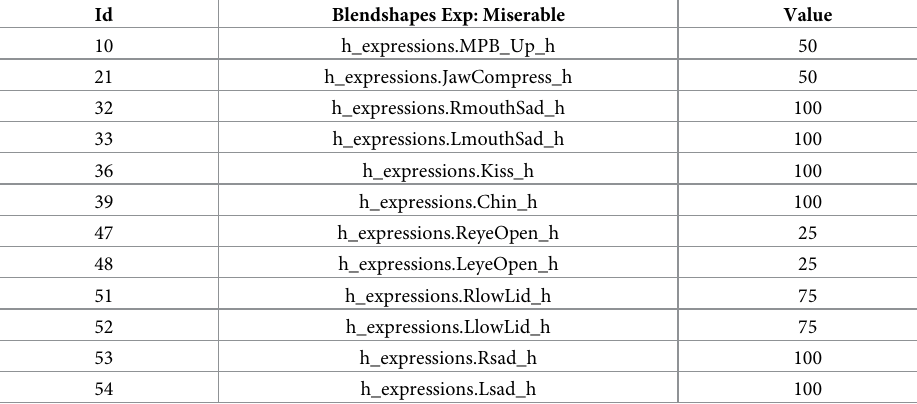
Table 1. Blendshapes for the sadness expression: Miserable . Id Blendshapes Exp: